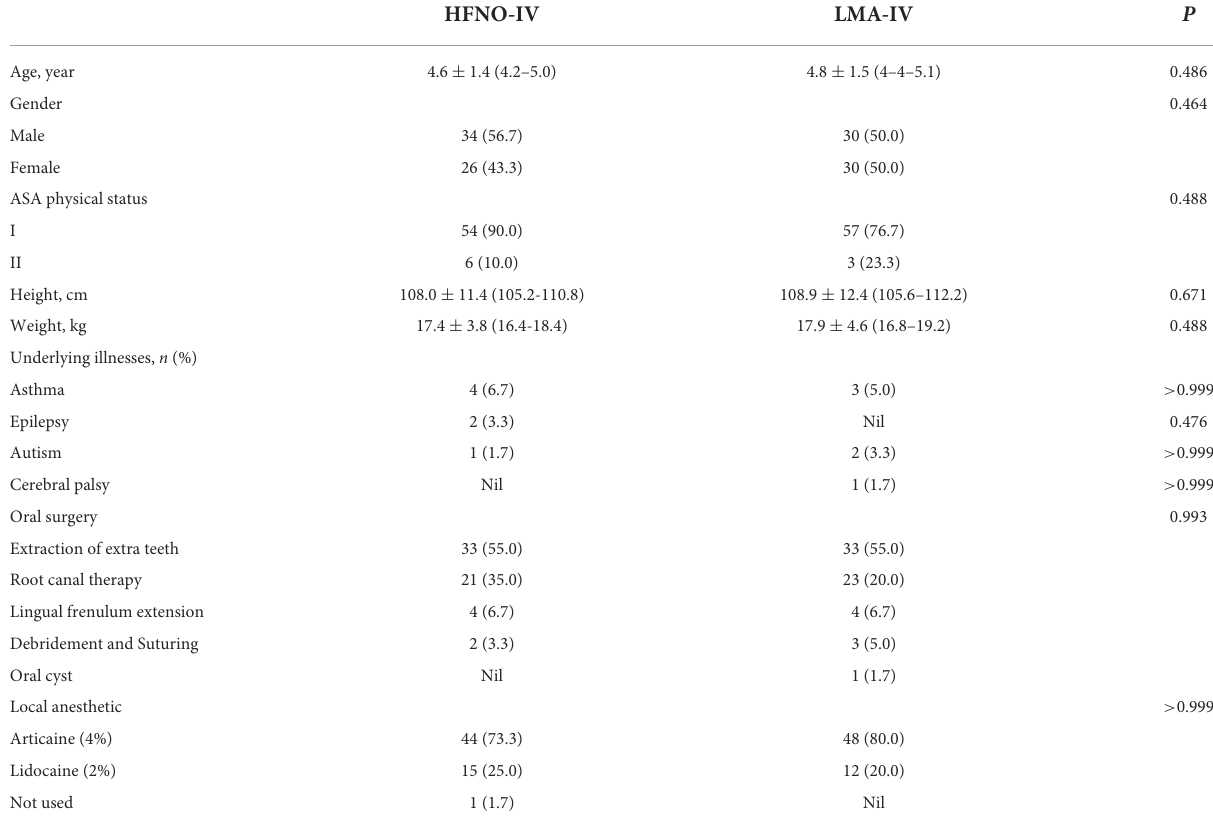
TABLE 1 Patient